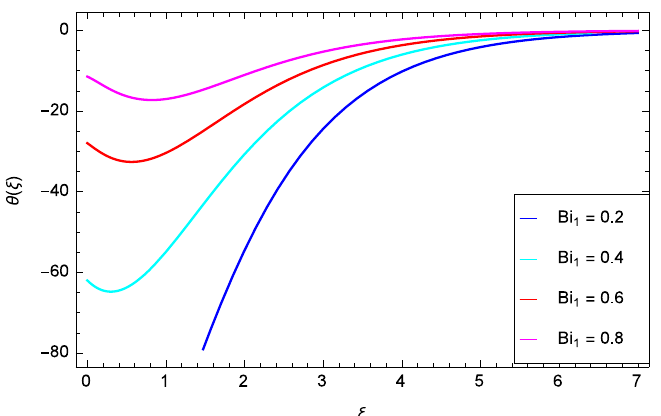
Figure 10. Impact of the thermal Biot number Bi 1 on temperature θ ( ζ ) .